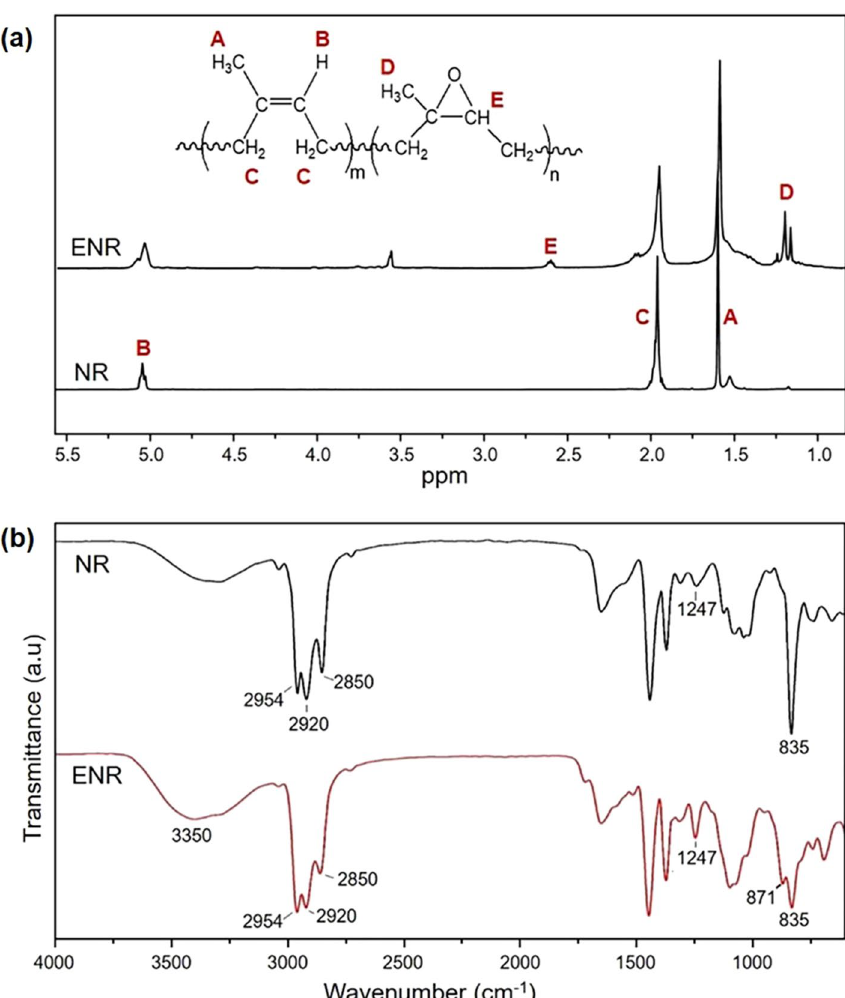
Figure 1. ( a ) 1 H-NMR spectra and ( b ) FTIR spectra of NR and